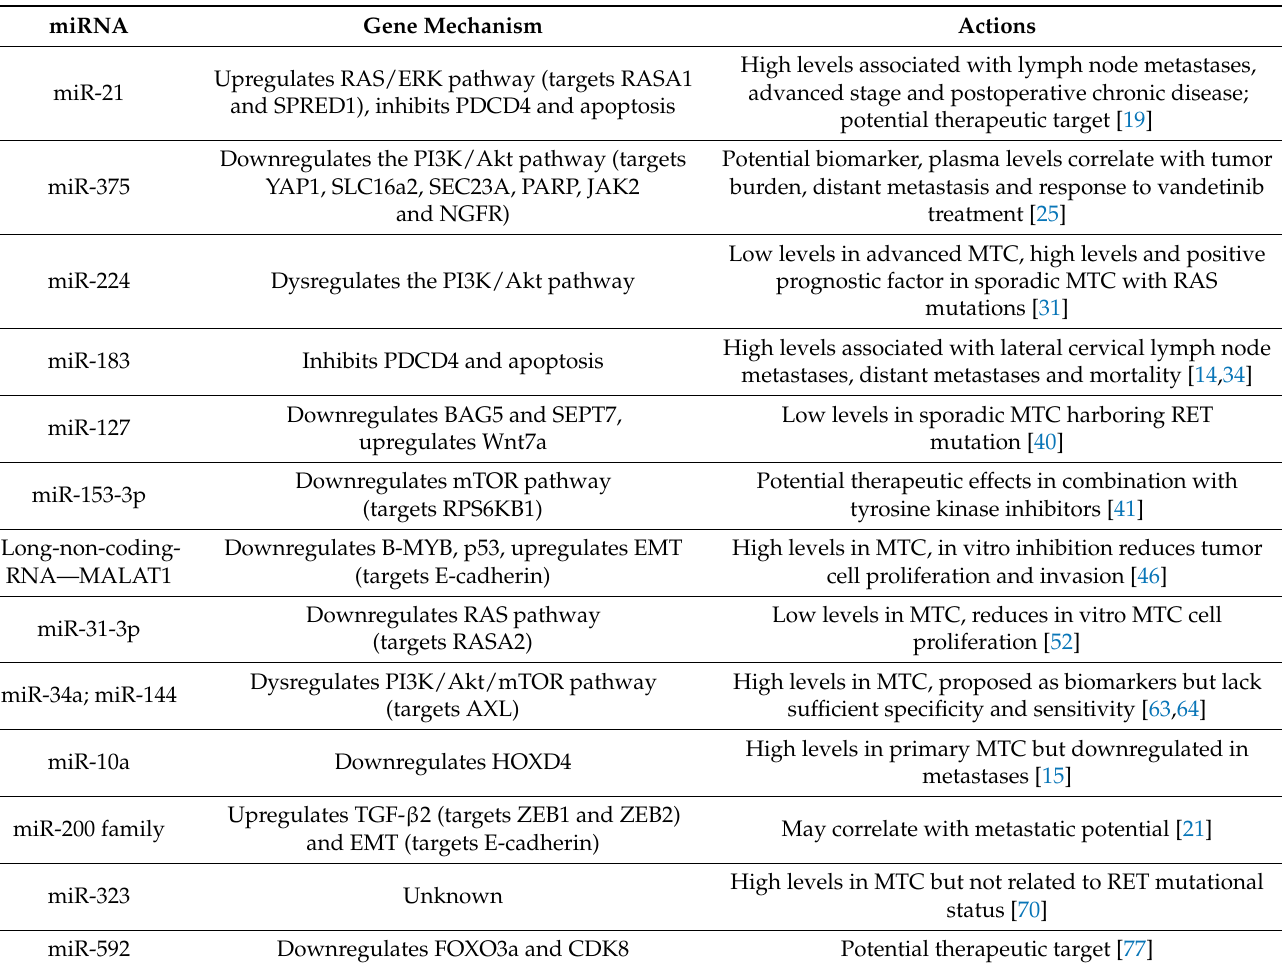
Table 1. The main miRNAs involved in medullary thyroid carcinoma, including gene mechanisms and actions. miRNA Gene